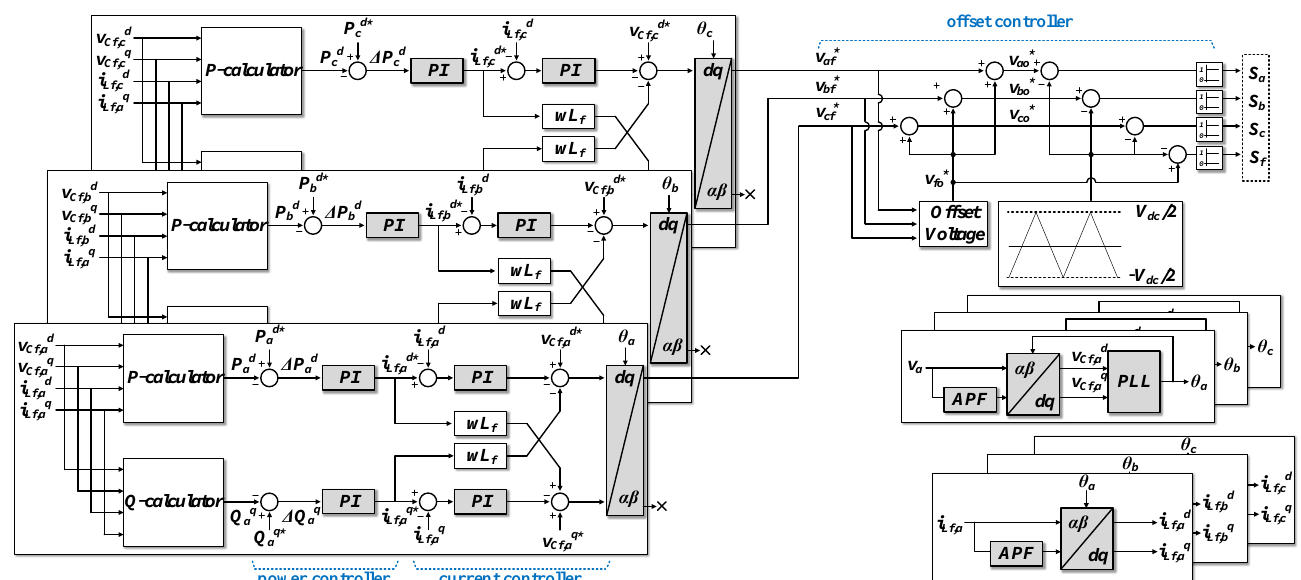
Figure 5. Block diagram of single-phase power control algorithm.